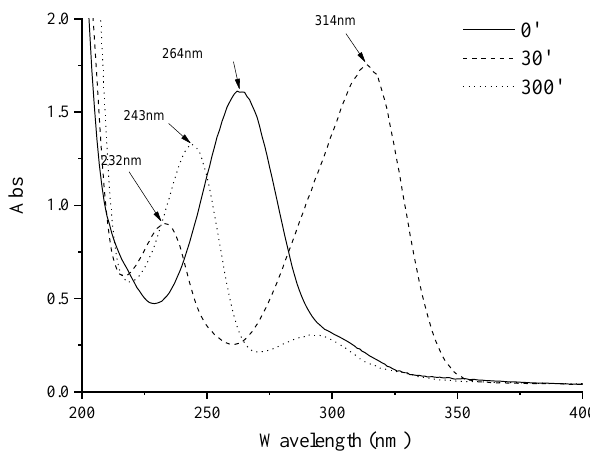
Figure 5. Spectral changes obtained upon visible irradiation (30 and 300 min) of a deaerated suspension of CdS/TiO 2 -2 (3 g/L) in CH 3 CN/2-PrOH (4/1, 3 mL) mixture containing NBA (1 × 10 − 4 M).